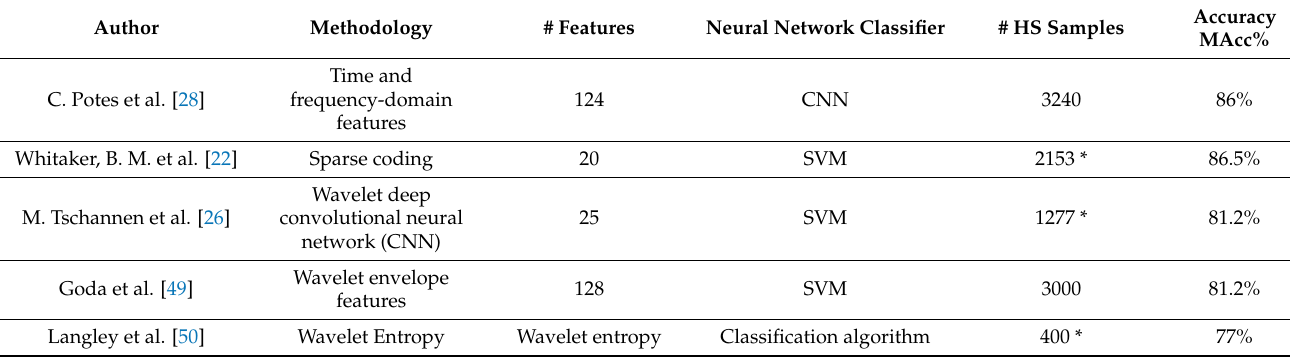
Table 5. Literature samples on PhysioNet Challenge 2016 using wavelet